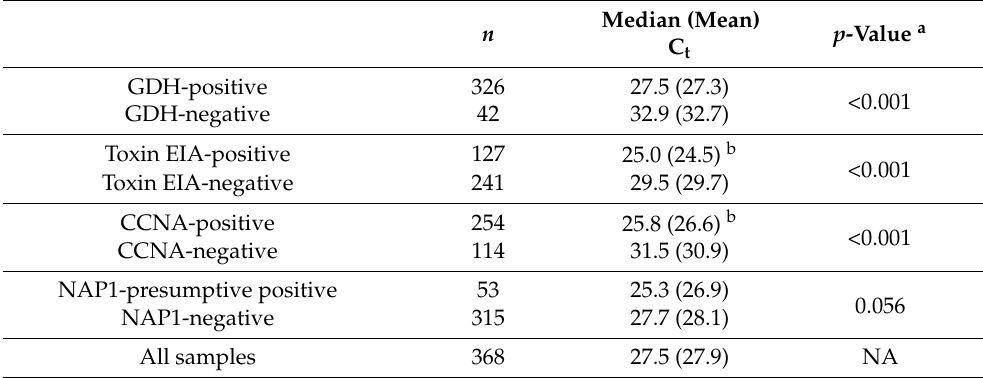
Table 2. Summary statistics of C t values for tcdB by GDH EIA, toxin EIA, CCNA, and PCR NAP1 results.